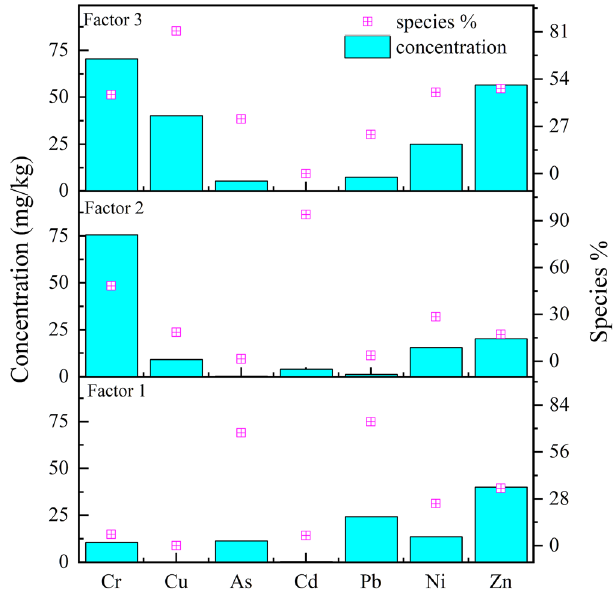
Figure 4. Fractional concentrations and factor contributions of (n =